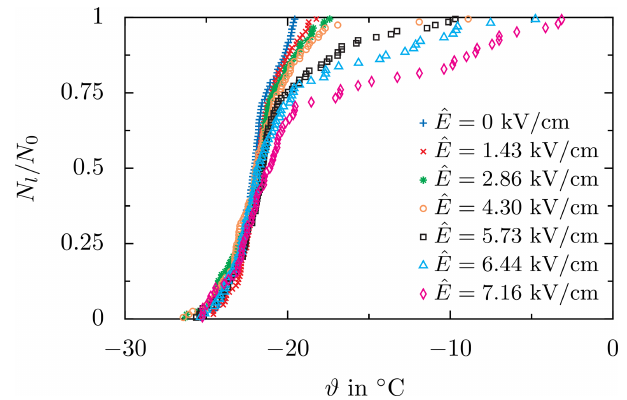
Figure 14. Droplet survival curves obtained for a constant cooling rate of ˙ T = 5Kmin − 1 and an alternating electric field with f = 50Hz and varying field strength ˆ E